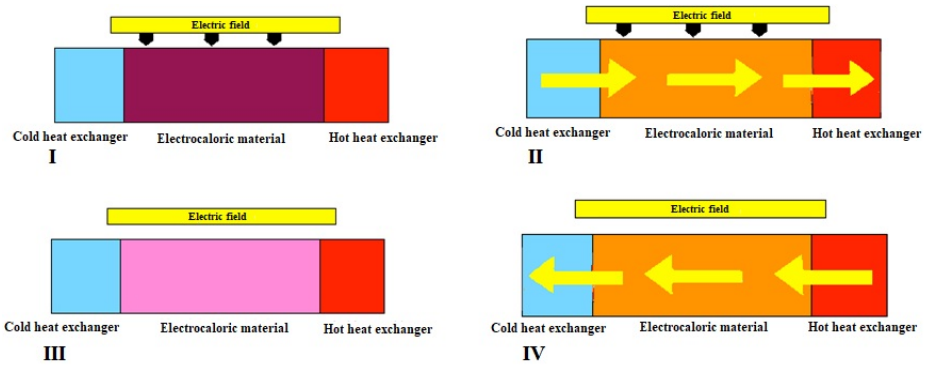
Figure 5. The four processes of the active electrocaloric regenerative refrigeration cycle.